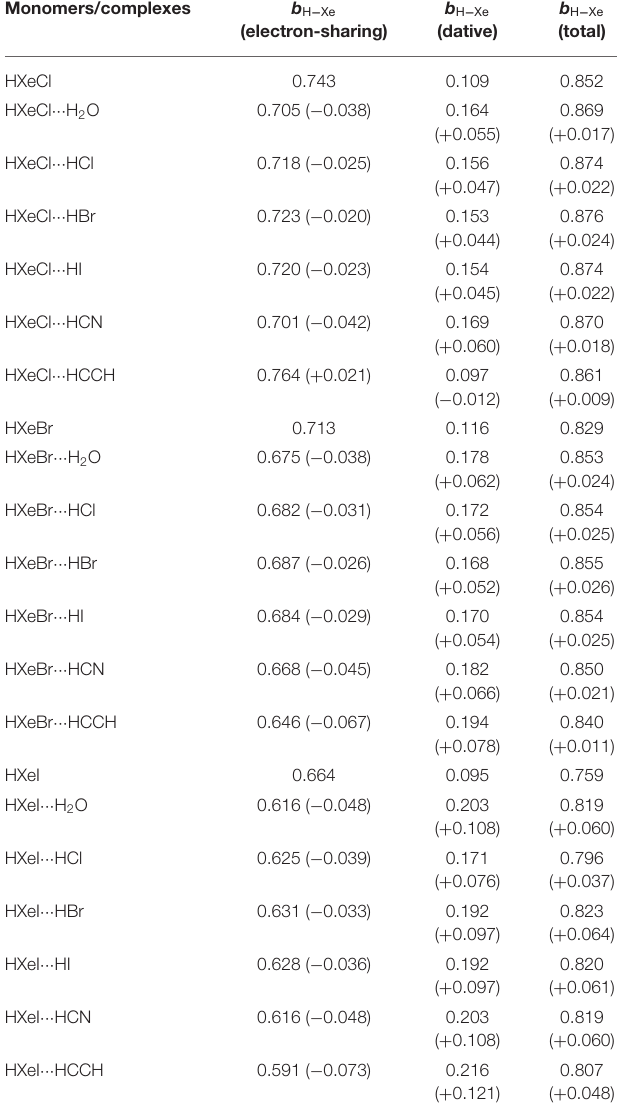
TABLE 2 | The bond orders ( b ) of H-Xe and H ∧ Y bonds for the monomer and their hydrogen-bonded complex, with the changes shown in parentheses. Monomers/complexes